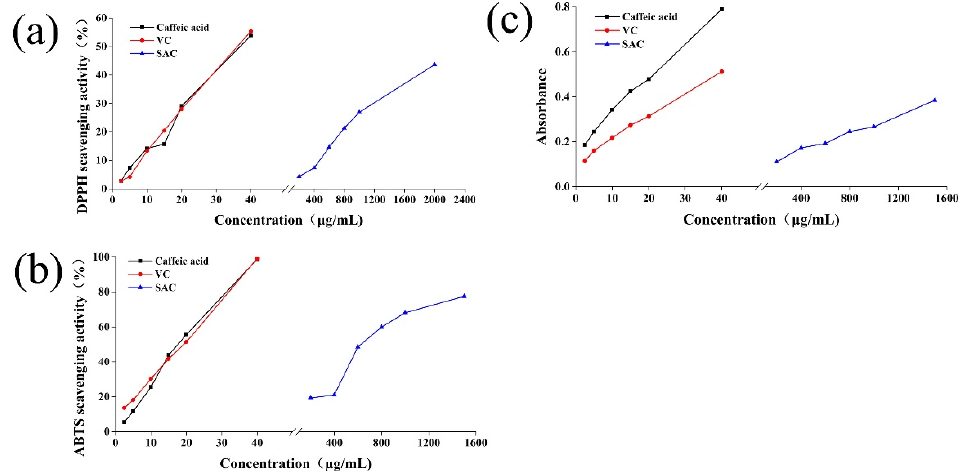
Figure 2. Antioxidant activity of caffeic acid, VC, and SAC at different concentrations. ( a ) 1,1-diphenyl-2-picrylhydrazyl (DPPH) free-radical-scavenging activity, ( b ) 2,2′-azino-bis-3-ethylbenzthiazoline-6-sulphonic acid (ABTS) radical-cation-scavenging activity, ( c ) reducing power.